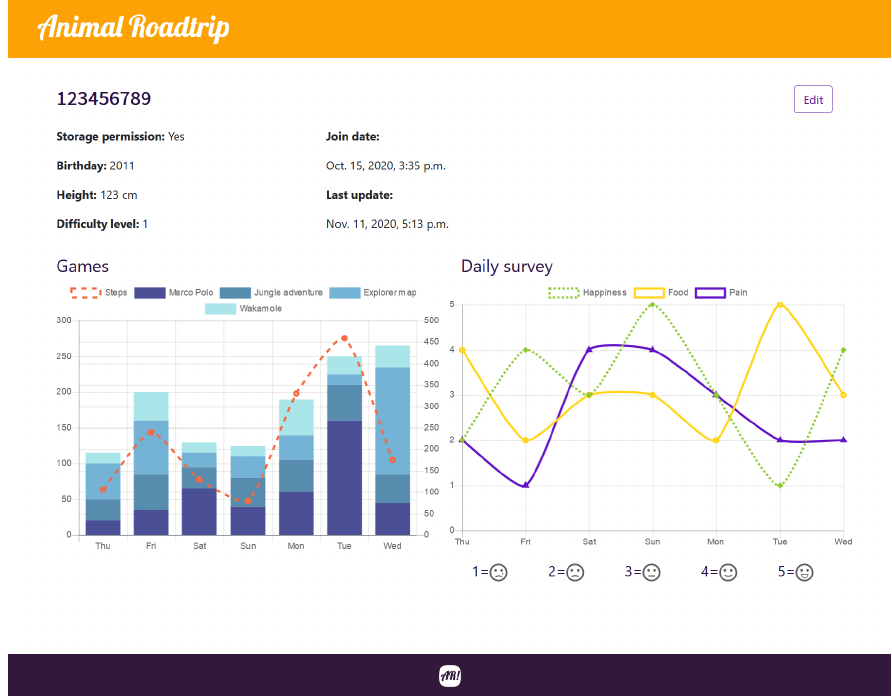
Figure 5. Patient data page of the developed web application.